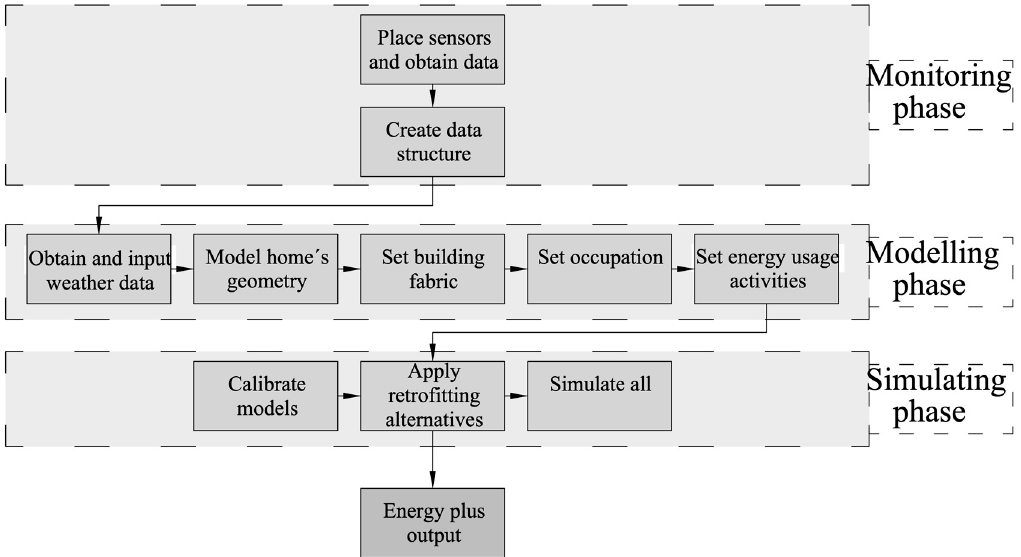
Figure 4. Stages of the simulation process. Stage 1 (monitoring phase) consisted of obtaining the sensors, ensuring their correct operation, and placement in the different houses. Stage 2 (modelling phase) surveyed the homes (measuring the perimeters and taking photographs). Later, these data were used in D.B. to create the simulation models. Finally, Stage 3 (simulation stage) consisted of simulations with the different building envelopes.